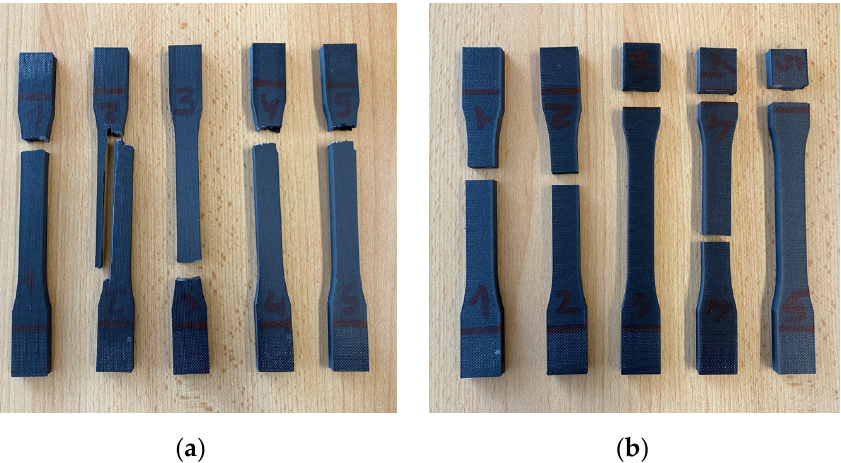
Figure 9. ( a ) Failure modes under tensile load for chopped FRP-0°; ( b ) failure modes under tensile load for chopped FRP-90°.